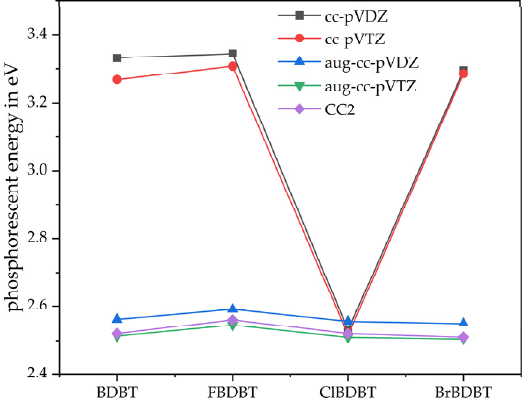
Figure 2. A comparison of the results of the BDBT, FBDBT, ClBDBT, and BrBDBT using four basis Table 4. The NBO analysis of the charge transfer and stabilization energy, E (2), of the AQs at